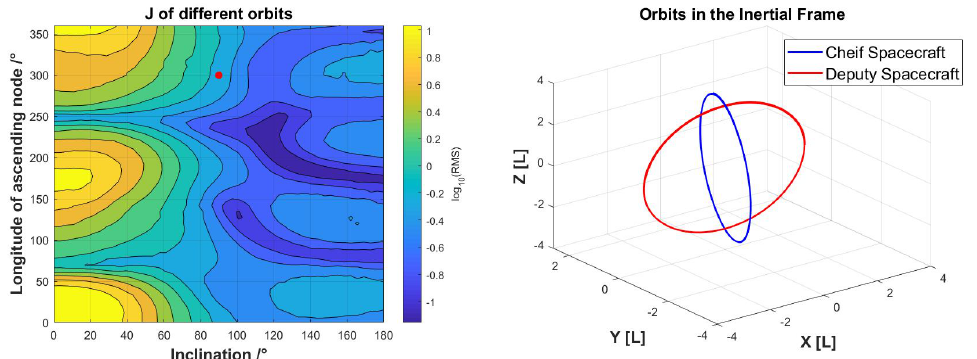
Figure 1. Contour map of measurement index J with 10 − 3 error in C 22 ( left ) and Orbit of the chief spacecraft and the deputy spacecraft ( right